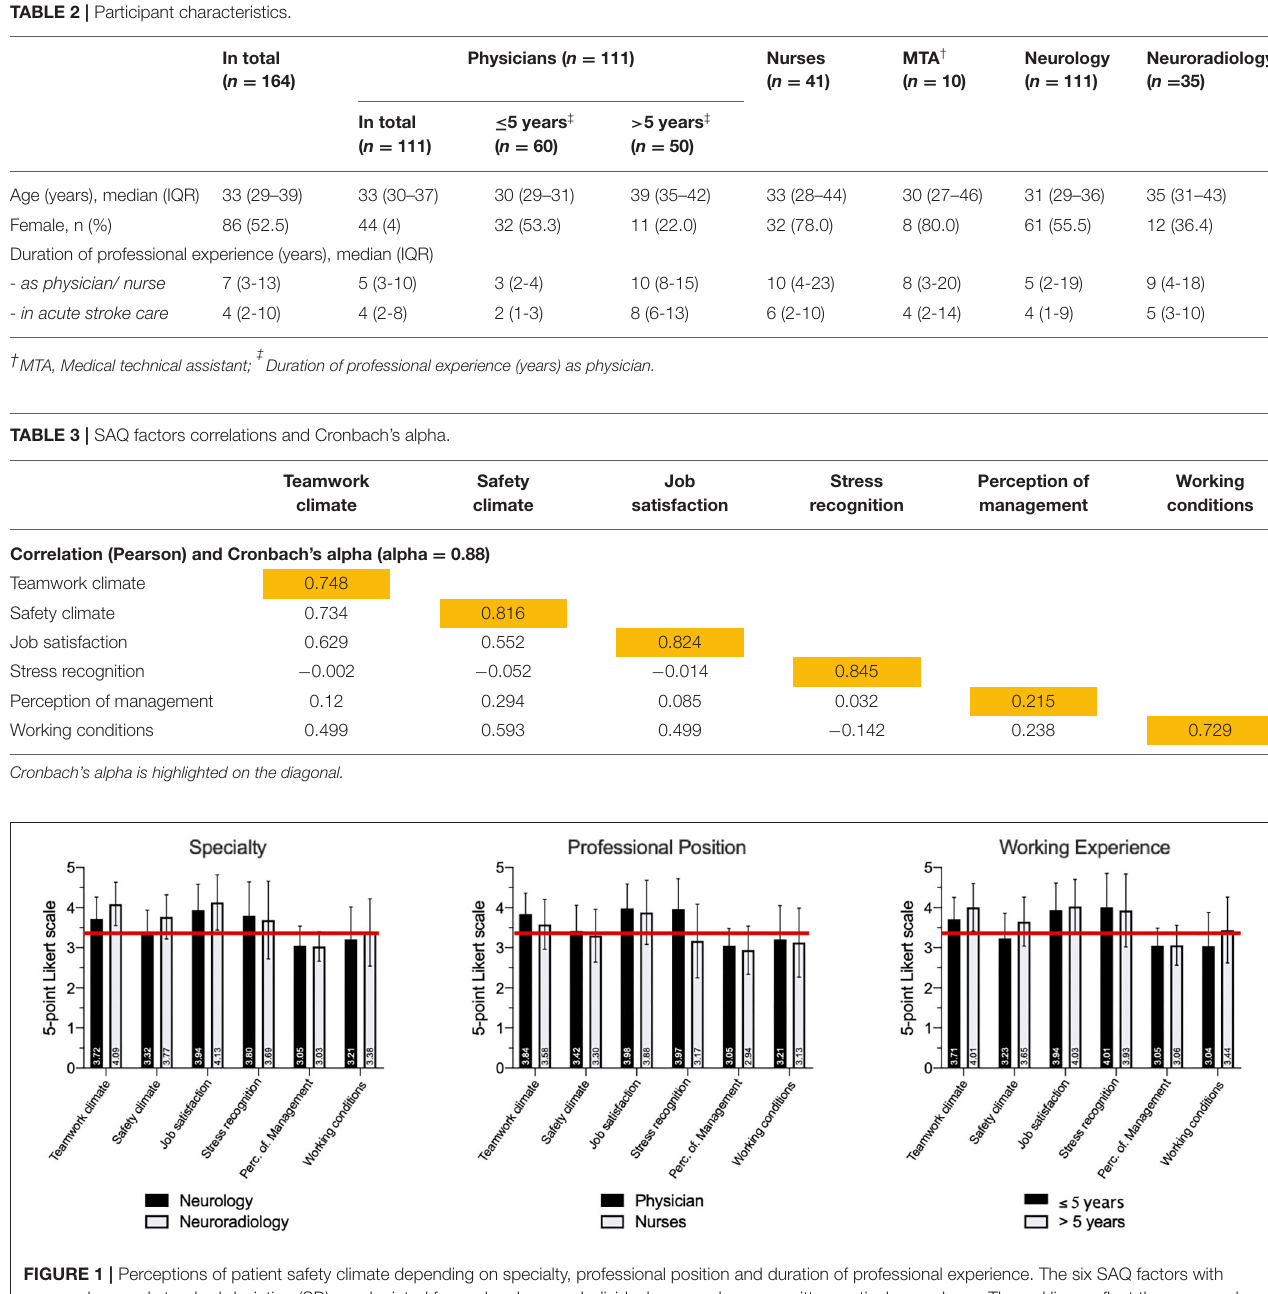
FIGURE 1 | Perceptions of patient safety climate depending on specialty, professional position and duration of professional experience. The six SAQ factors with mean values and standard deviation (SD) are depicted for each subgroup. Individual mean values are written vertical per column. The red lines reflect the proposed benchmark of 3.4 points. Perc. of Management: Perception of